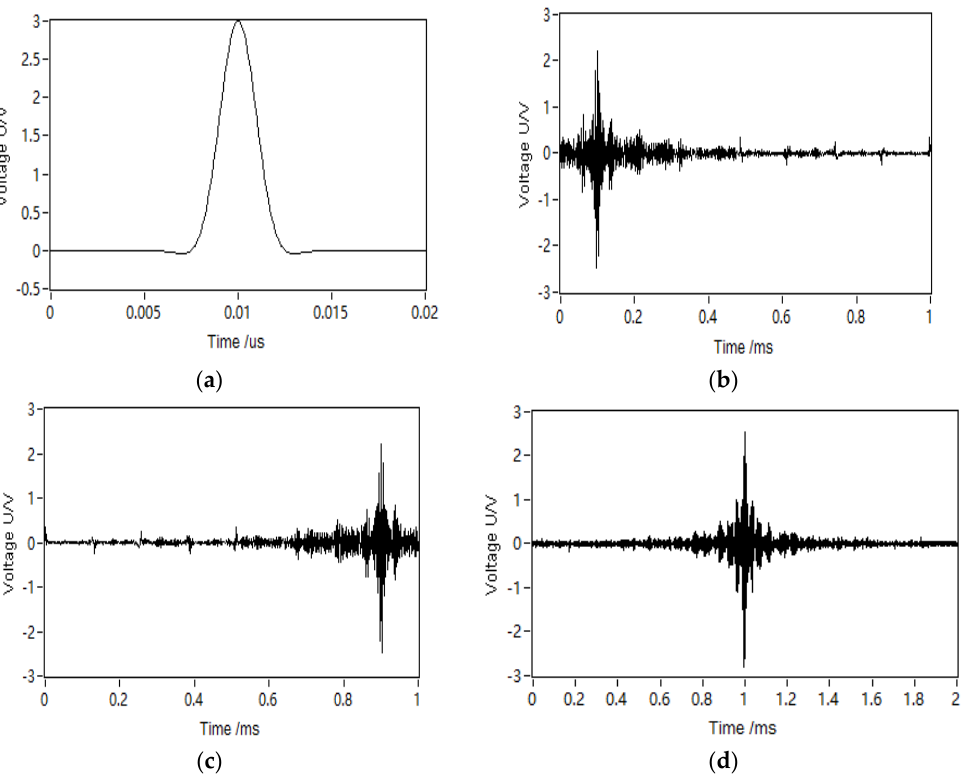
Figure 7. Experimental signals. ( a ) Pulse signal; ( b ) Response signal; ( c ) Time reversed signal; ( d ) Focused signal.